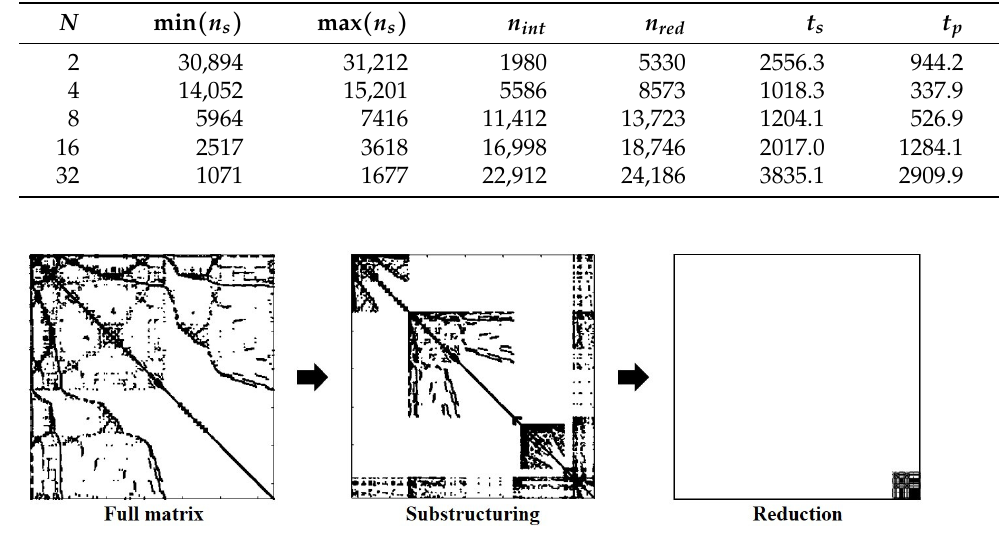
Figure 7. Illustration of reduction process of the shaft assembly.